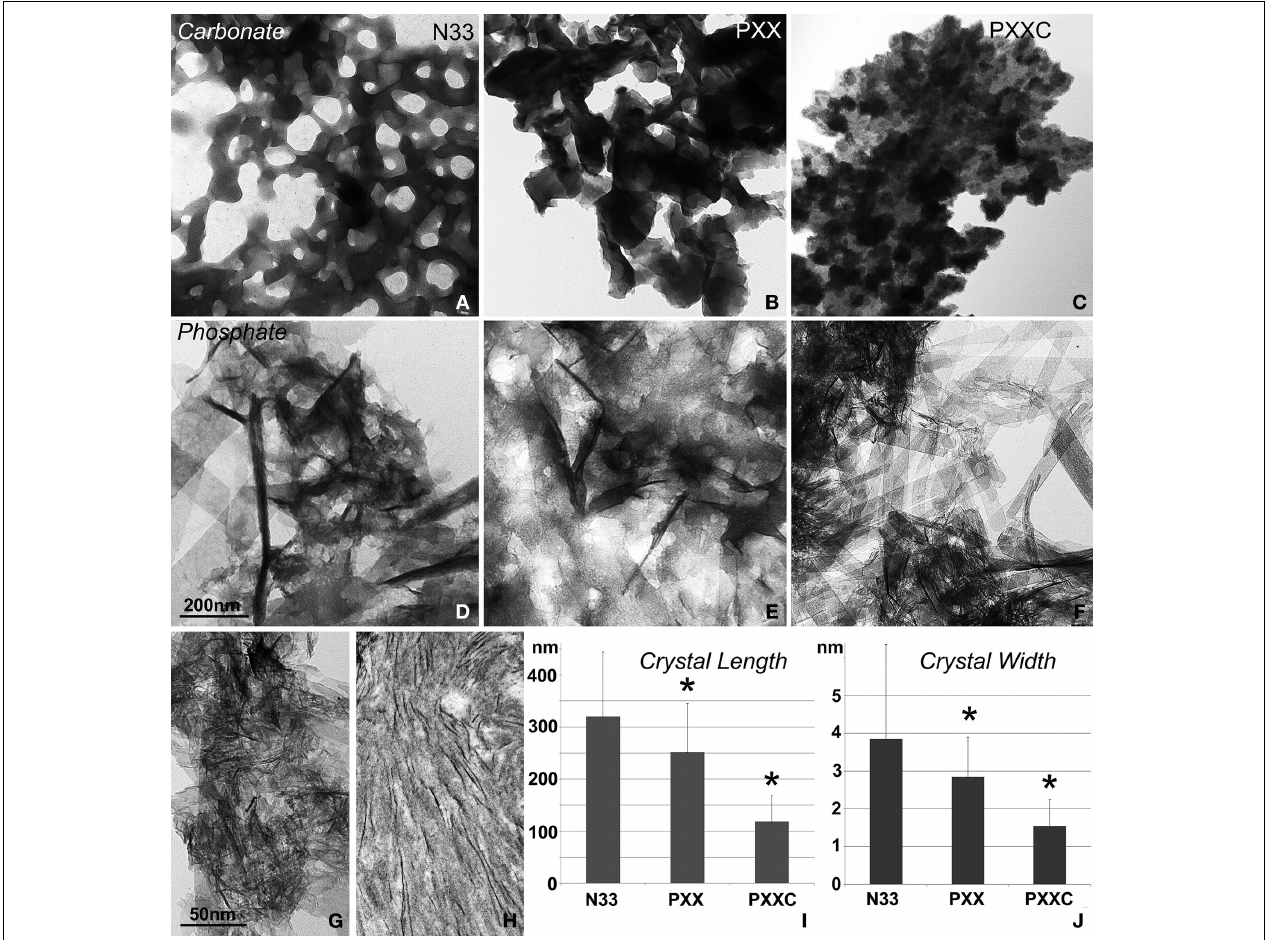
FIGURE 2 | Effect of amelogenin fragments on calcium carbonate and calcium apatite crystal growth. (A – C) demonstrates the effects of three different amelogenin fragments on carbonate crystal growth, including the N-terminal 33 amino acids (N33, A ), the PXX repeat region alone (PXX, B ), and the PXX region augmented by the hydrophilic C-terminus (PXXC, C ). (D – F) is similar to (A – C) , but illustrates the effects of the same amelogenin fragments on calcium phosphate crystal growth, including the N-terminal 33 amino acids (N33, D ), the PXX repeat region